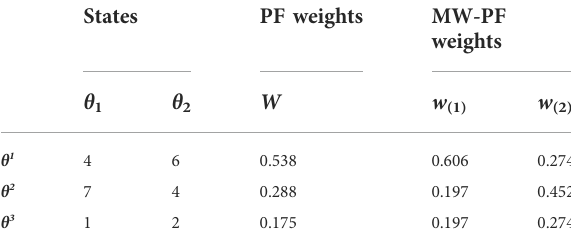
TABLE 1 Summary of values and weights of